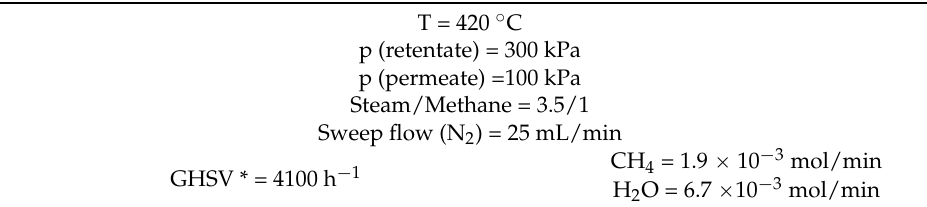
results in terms of methane conversion, hydrogen recovery and yield. Table 4. Operating conditions during MSR reaction tests in the Pd-Au MR. Table 4. Operating conditions during MSR reaction tests in the Pd ‐ Au MR.